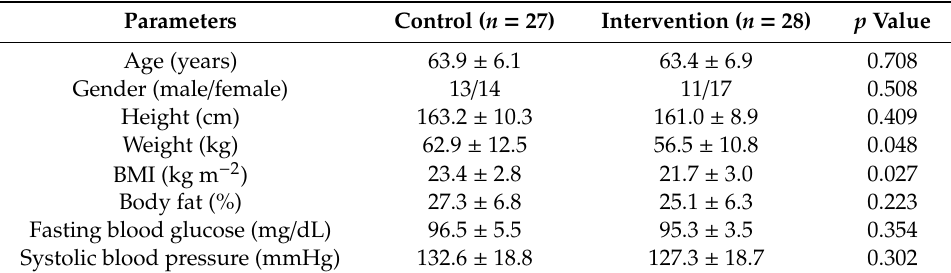
Table 2. Baseline characteristics of the study subject.